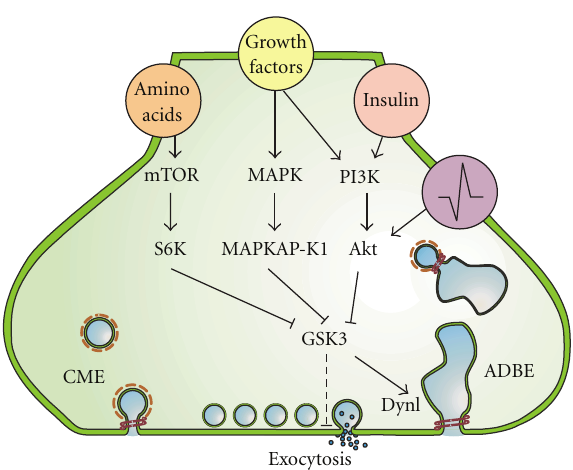
Figure 2: GSK3-dependent control of SV recycling in mature nerve terminals. When GSK3 is active, it phosphorylates Ser774 on dynamin I, which inhibits the interaction between dynamin I and syndapin I. This interaction is essential for the triggering of activity- dependent bulk endocytosis (ADBE) and thus during high-intensity stimulation GSK3 is inhibited in an activity-dependent manner by Akt (action potential symbol). After stimulation, GSK3 is active and can rephosphorylate dynamin I. If the rephosphorylation of dynamin I by GSK3 is inhibited, the subsequent cycle of ADBE is arrested. Signal transduction cascades that may regulate GSK3 activity in the longer term are: a mammalian target of rapamycin (mTOR)/S6 kinase pathway (activated by amino acids), a PI3K/Akt pathway (activated by either insulin or growth factors), or a mitogen-activated protein kinase (MAPK)/MAPKAP-K1 pathway (activated by growth factors). GSK3 has no role in clathrin- mediated endocytosis (CME). GSK3 may perform an additional role in SV recycling by negatively regulating neurotransmitter release (dotted line). This is because GSK3 is proposed to phospho- rylate P/Q-type calcium channels and inhibit calcium influx into the nerve